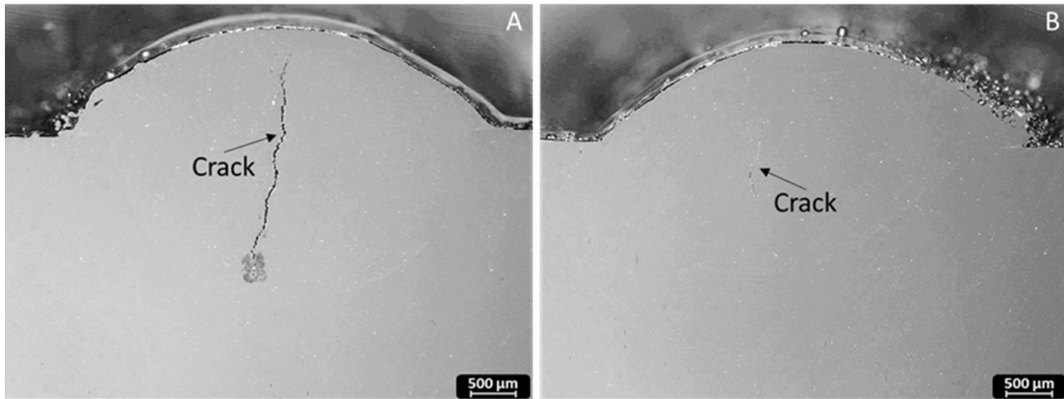
Figure 7. OM images of cracks formed in the centre of the cladding in M3_6_10 samples ( A ) with and ( B ) without PHT.